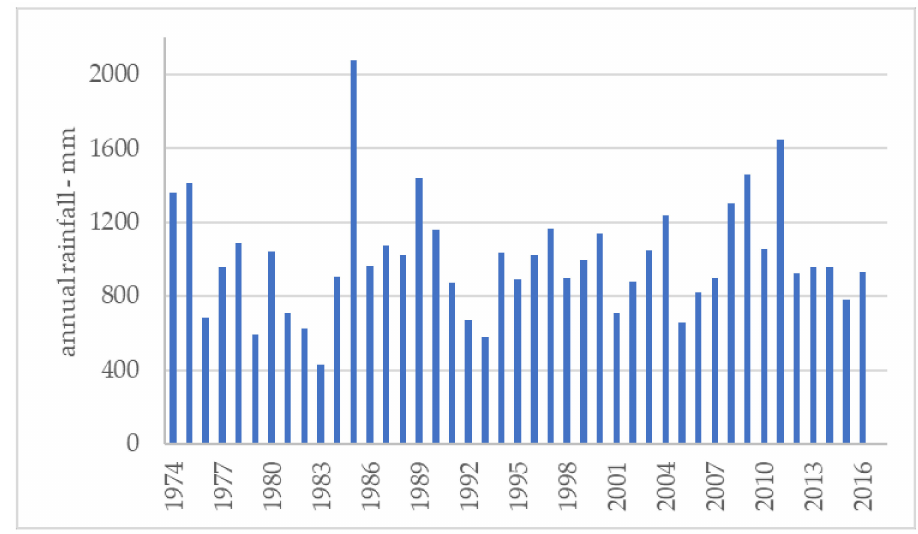
Figure 4. Long-term annual rainfall from 1974 to 2017, Iguatu,